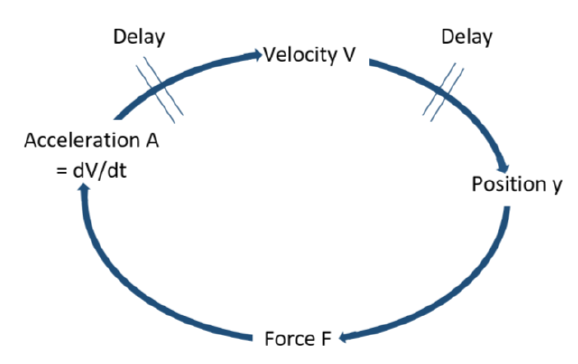
Fig. 17. Spring-mass causal loop